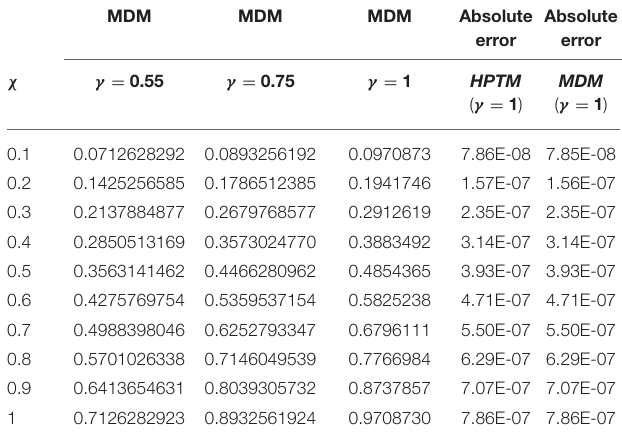
TABLE 1 | Comparison of MDM and HPTM [49] of example 1 at ℑ =